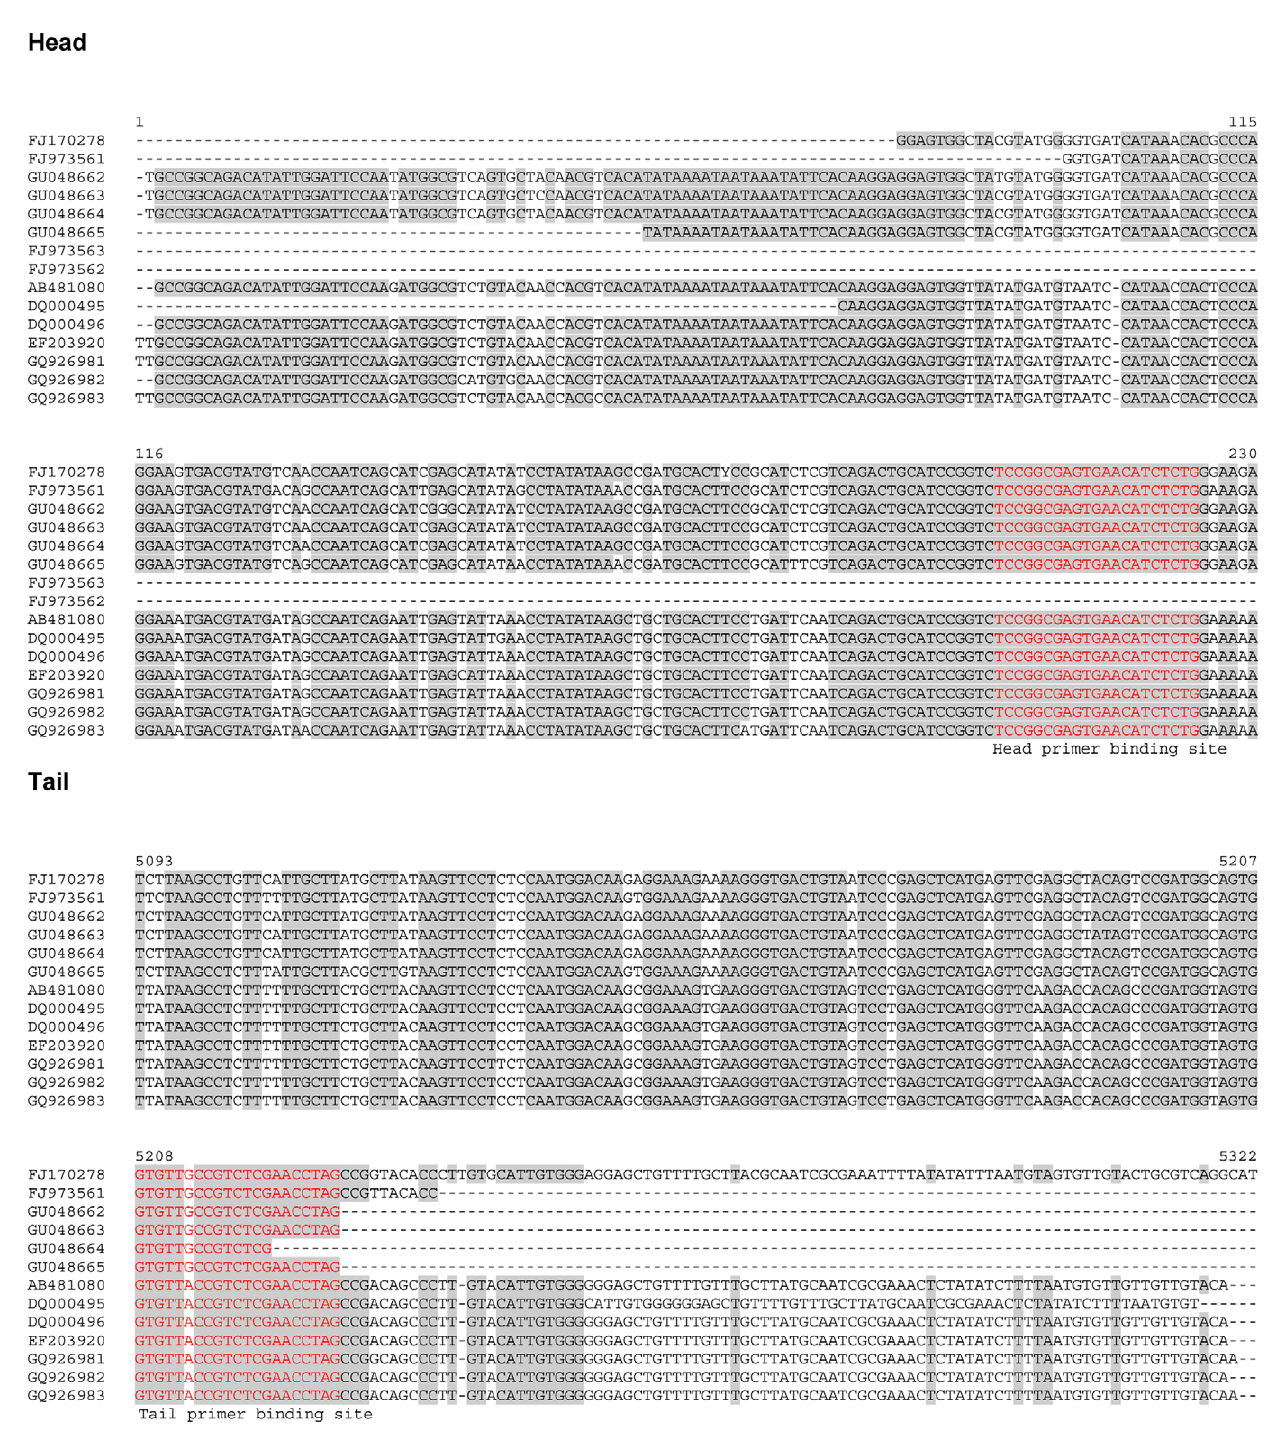
Figure 3. Alignment of head and tail sequences of several published HBoV isolates. Most isolates differ in the length of the published sequences. Red boxes indicate primer binding sites of the head and tail primers used in this study, respectively. Nucleotide numbering is according to the longest isolate sequences used in the alignment.